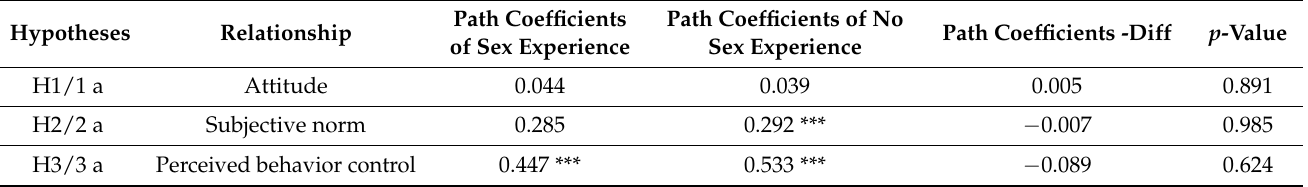
Table 5. Result of PLS-MGA (sex